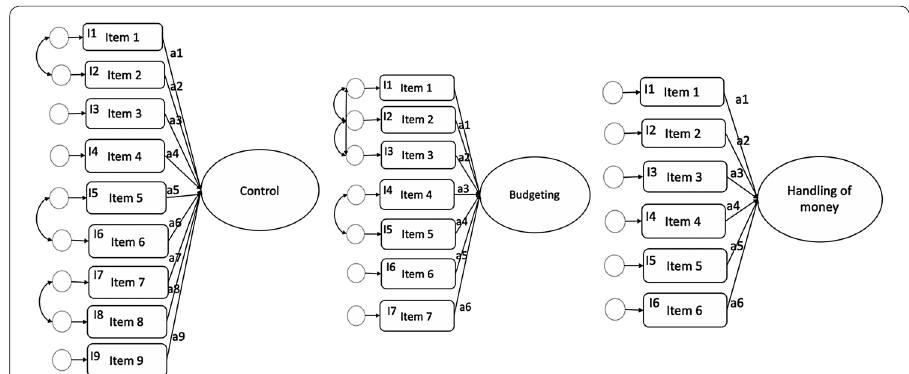
Fig. 2 Measurement model of the three facets of financial